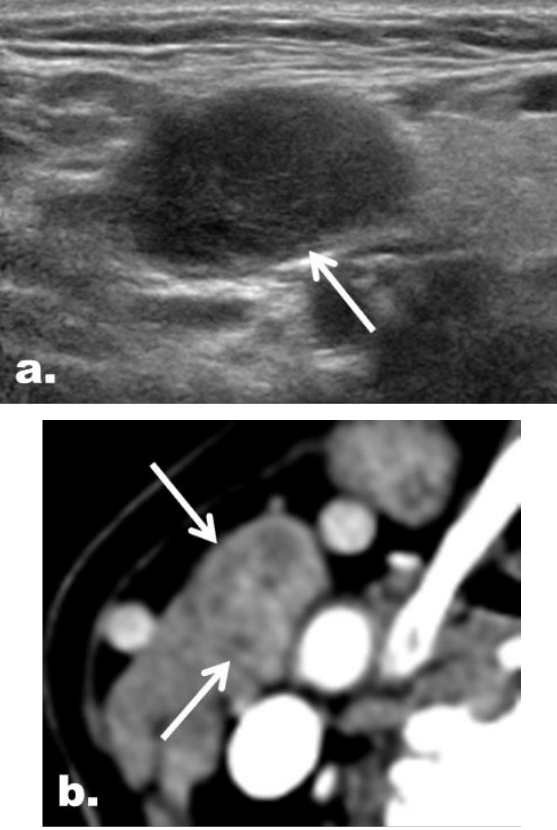
Figure 4. Representative case of a discordant suspicious LN with the final diagnosis of a benign LN in a 61-year-old woman with PTC. ( a ) On US, an ovoid LN (arrow) at the right neck level II had neither echogenic hilum nor suspicious feature and therefore was classified as an indeterminate LN. ( b ) On CT, LN (arrows) was interpreted to have a heterogeneous enhancement and was classified as a suspicious LN.